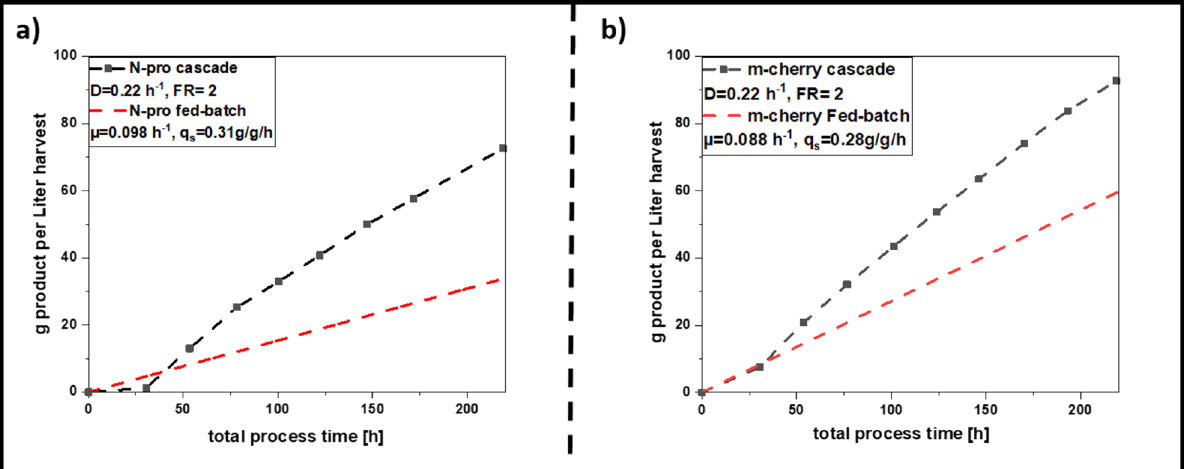
Figure 7. Space–time-yield calculated over the total process time for a fed batch and the cascaded continuous cultivation; For fed batches the maximum achieved titers were 5.09 g/L for the N-pro protein and 8.96 g/L for mCherry after each induction phase, CIP + SIP were assumed with 6 and 3 h respectively, batch phase with 6 h and non-induced fed-batch/continuous adaption phase with 12 h. Induction time for fed-batches was calculated with 10 h resulting in the dotted red lines, whereas cascaded continuous cultivation was calculated using cleaning and set-up times stated before, with the time-dependent results measured throughout induction phase given in the black curves for ( a ) N-pro and for ( b ) mCherry ( FR feed ratio, D dilution rate, CIP clean-in-place, SIP